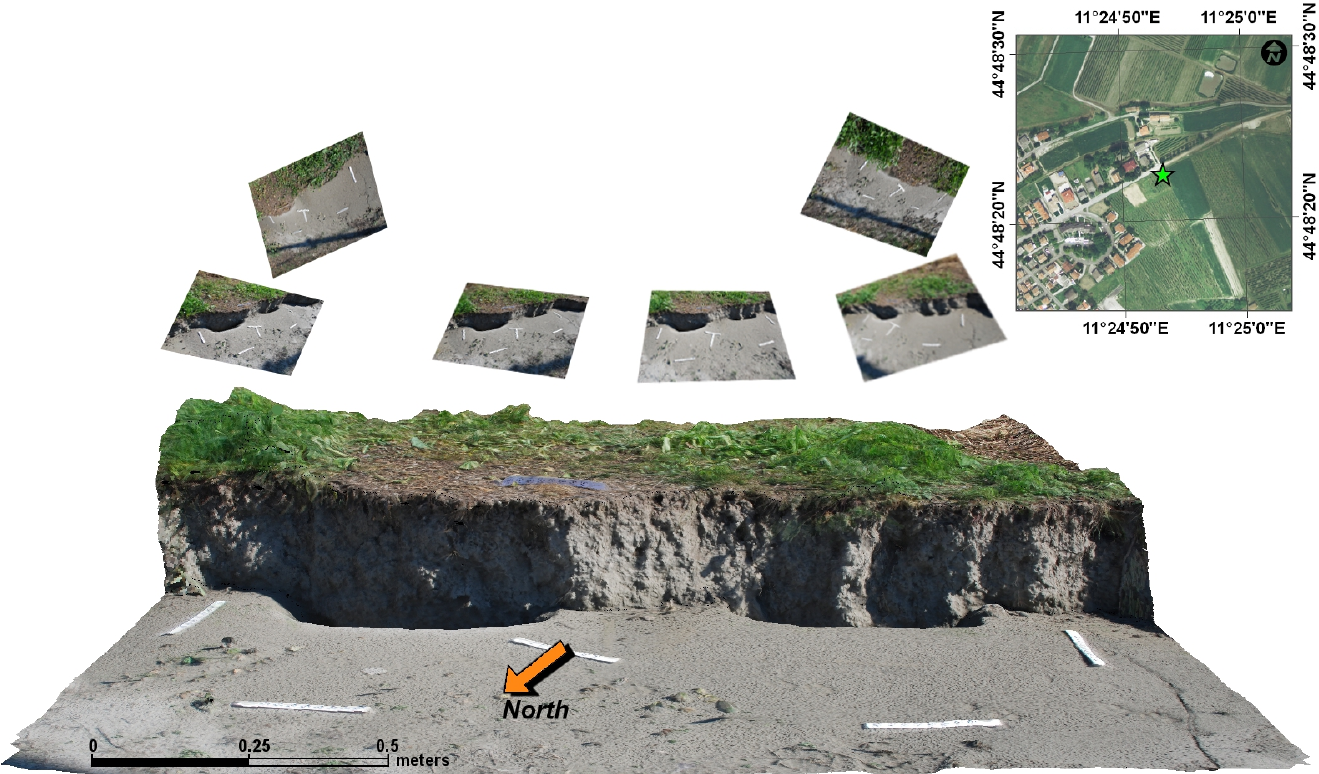
Figure 2. Textured point cloud obtained by dense stereo-matching algorithms and camera position reconstruction. These fractures were in San Carlo.